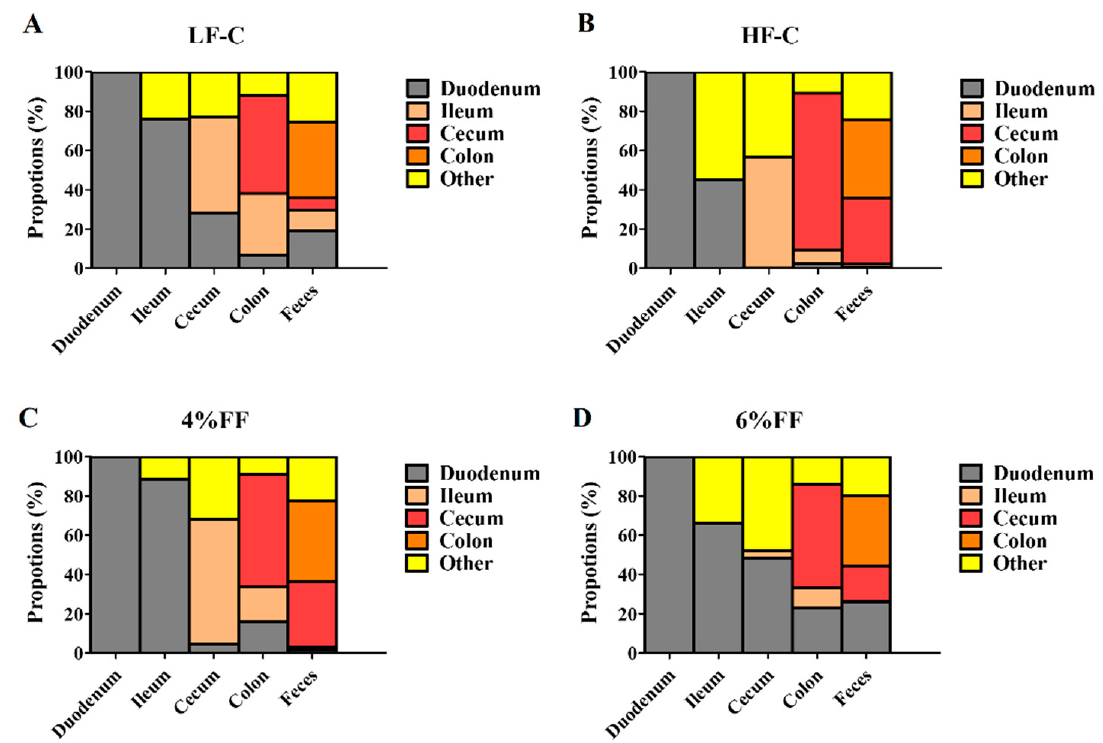
Figure 9. Tracing the source of OTUs in each intestinal segment ( A – D ). The anterior intestinal segment samples were taken as potential sources of the latter intestinal segment. The chart indicates the top 100 most abundant OTUs.